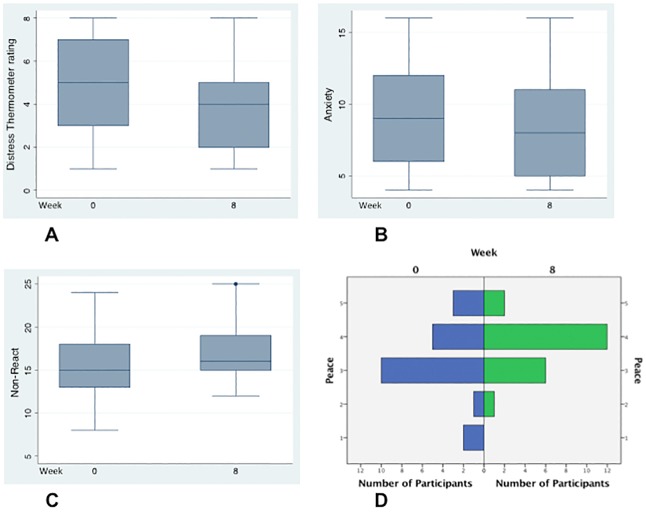
Graphic representations of survey scores at baseline and week 8.N = 24. A) Box plots of National Comprehensive Cancer Network (NCCN) Distress Thermometer ratings: 0 = no distress; 10 = extreme distress. B) Box plots of National Institutes of Health Patient Reported Outcomes Measurement Information System (NIH PROMIS) Anxiety Short Form 4A scores. C) Box plots of Five Facet Mindfulness Questionnaire Short Form (FFMQ-SF) “Non-React” scores. D) Histograms of “Are You at Peace?" one-item spiritual probe ratings: 1 = not at all; 2 = a little bit; 3 = a moderate amount; 4 = quite a bit; 5 = completely. See Table 6 for P-values from paired t-tests.